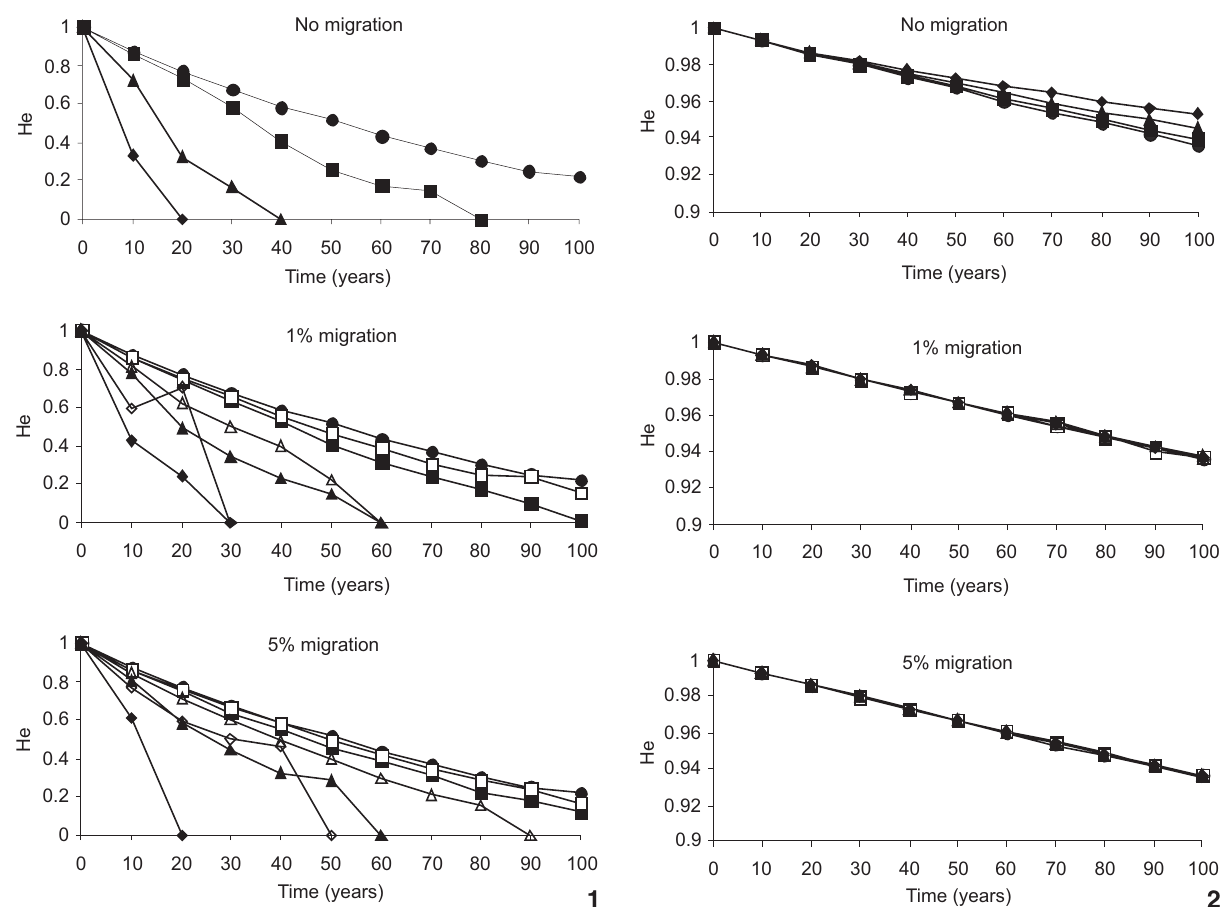
Figures 1-2. Loss of gene diversity over 100 years from metapopulations of M. paraguayanus with carrying capacity of 100 (1) and 2000 (2), divided into 1 ( (cid:2) ), 2 ( (cid:3) ), 5 ( (cid:2) ) or 10 ( (cid:4) ) subpopulations connected by different migration rates (0%, 1% or 5%) and by equal dispersal by both sexes (white) and male-biased dispersal